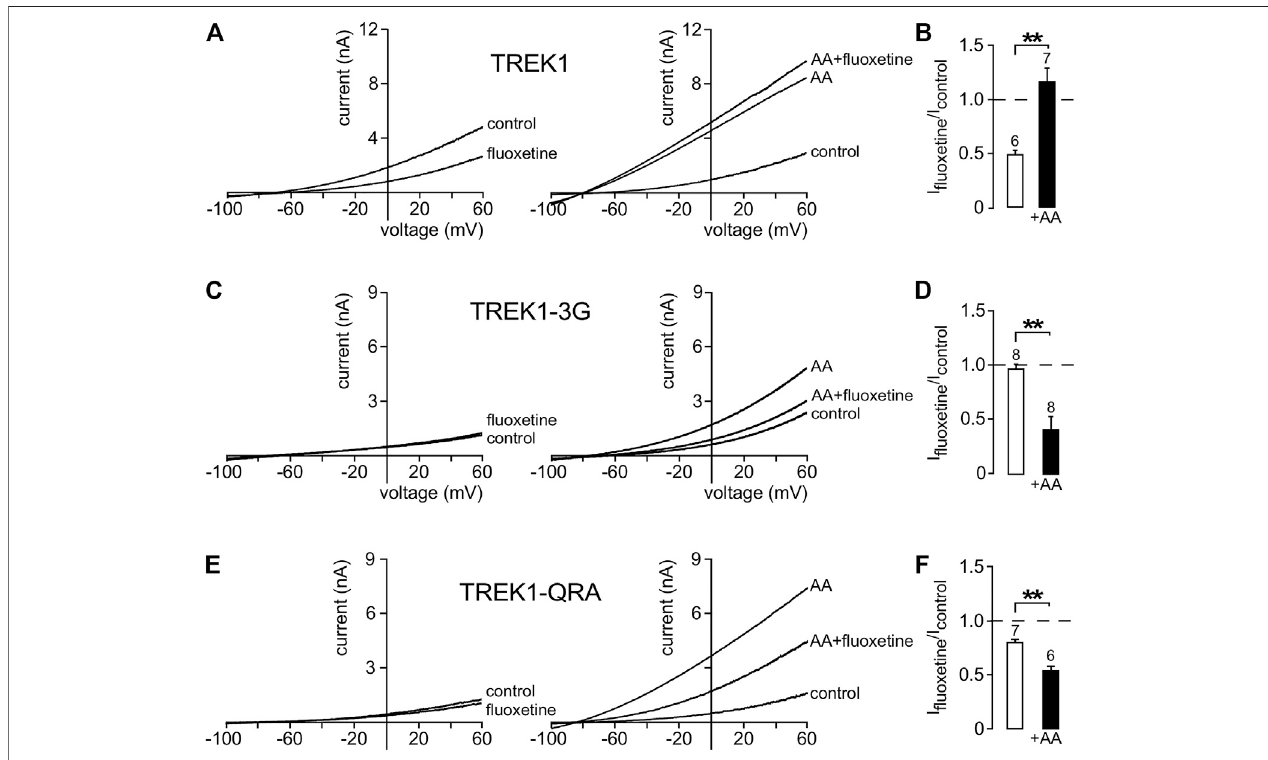
FIGURE 6 | State-dependent inhibitory effect of fl uoxetine. (A, C, E) Representative whole-cell currents from cells transfected with TREK1 (A) , TREK1-3G (C) and TREK1-QRA (E) channelsinthepresenceorabsenceof10 μ M fl uoxetineonbasalcurrents (leftpanel) andoncurrentsstimulatedbyAA(10 μ M) (rightpanel) . (B,D,F) Fractionof fl uoxetine-sensitivecurrentintheabsenceorpresenceofAA(10 μ M).Dataarepresentedasmean ± SEM,thenumberofcellsisindicated, pp p < 0.01(Mann- Whitney test).